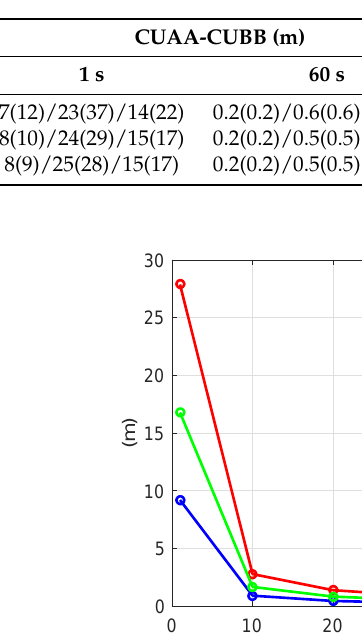
Table 3. Empirical and average formal (in brackets) standard deviations of the ambiguity-float baseline errors for the phase-only two-epoch scenario. The data on DOY 240, 2018, was used for the computation. The results are given in the format of the north/east/up directions.